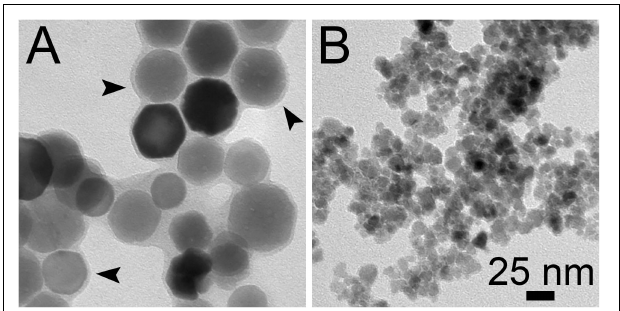
FIGURE 1 | Transmission electron microscopy images of BMNs isolated from a Magnetospirillum gryphiswaldense strain MSR-1 (A) and synthetic iron oxide nanoparticles (B) prepared by co-precipitation (Santos et al., 2018). Arrowheads indicate external BMN membrane, which is retained after isolation